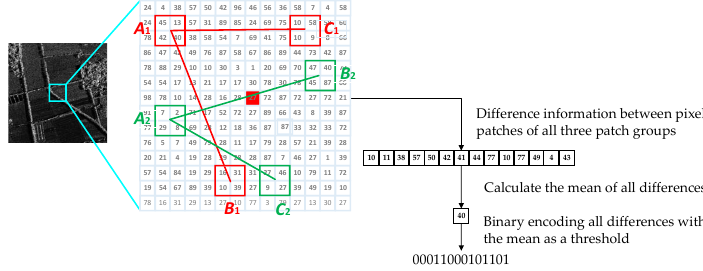
Figure 2. Binary string using gray di ff erence value